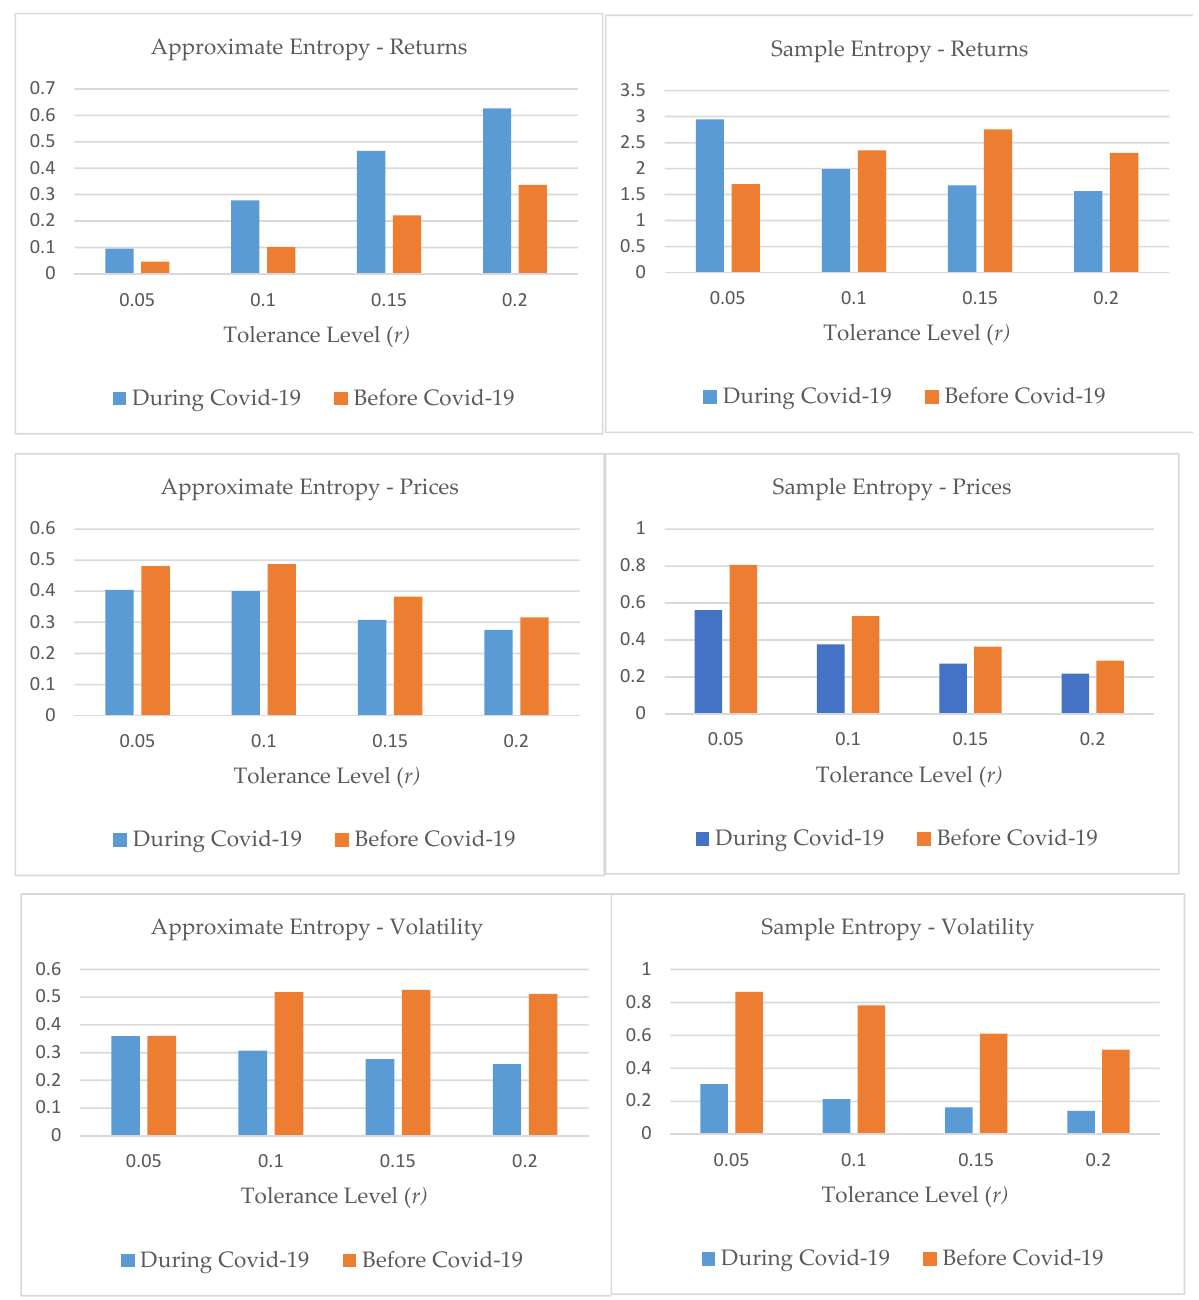
Figure 5. The plot of the approximate entropy and sample entropy estimates for estimated volatility series, closing prices and closing returns of PSX-100.